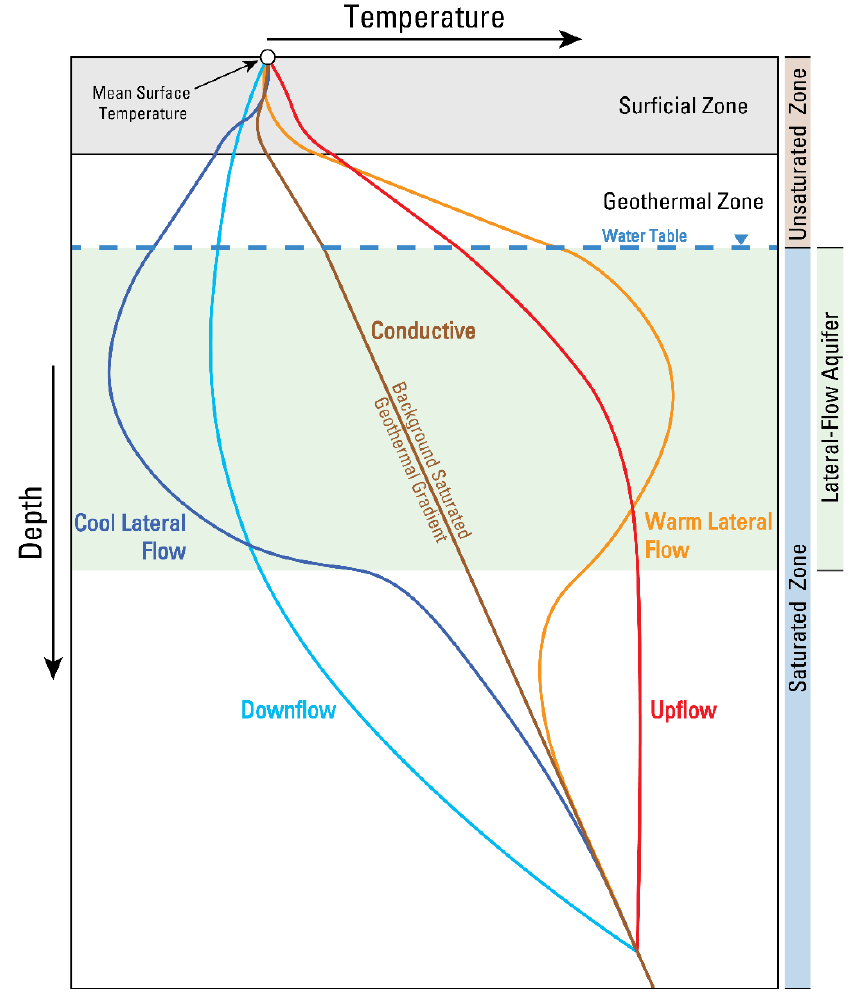
Figure 2. Schematic showing typical temperature profile deviations from the conductive case be- cause of horizontal or vertical groundwater flow. The surficial zone refers to depths in which temperatures are influenced by relatively short-term (e.g., daily, seasonal) temperature variations.